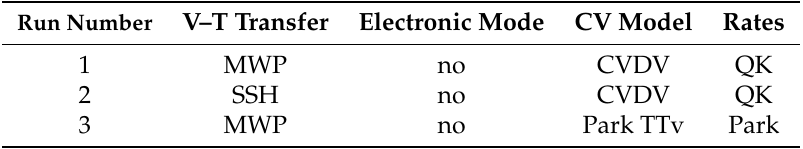
Table 3. Computational fluid dynamics (CFD) simulations performed.